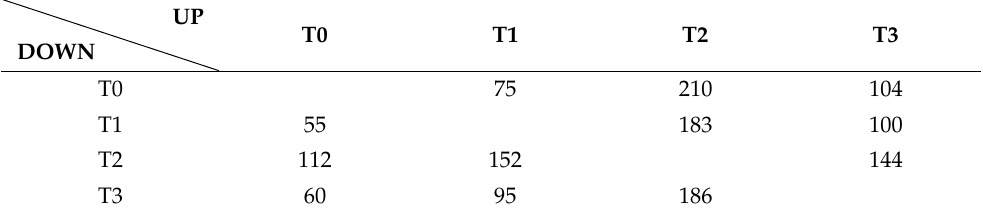
Table 5. The number of up-regulated and down-regulated differentially expressed